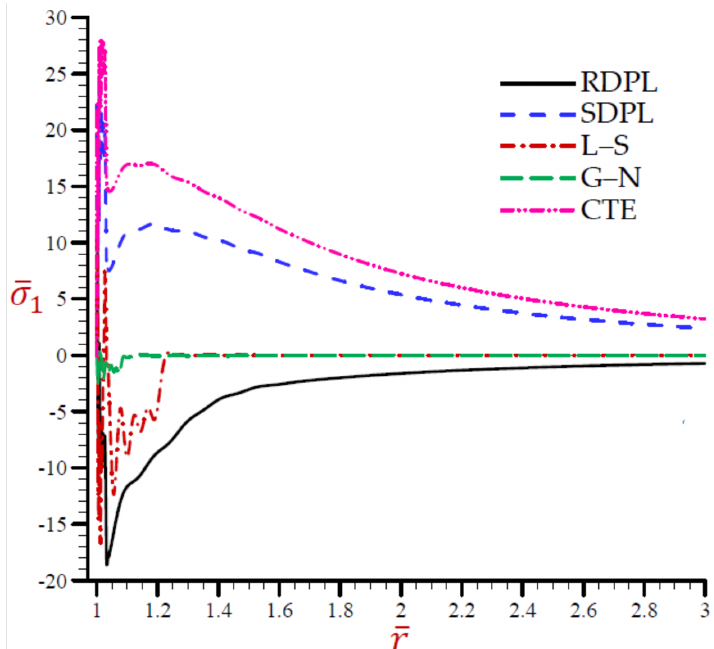
Figure 4. The radial stress σ 1 across the radial direction of the cylindrical cavity conferring to all theories.